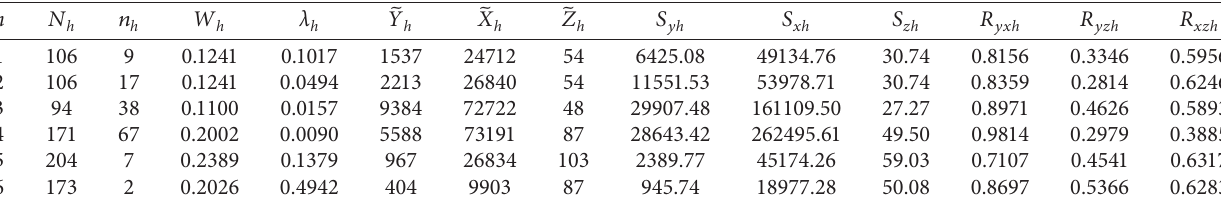
Table 5: Data description of population 2 (scenario II).